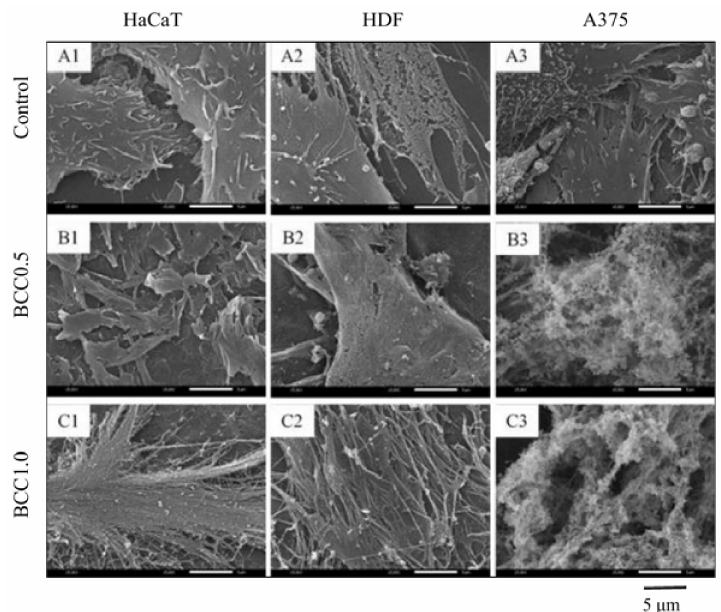
Figure 8. SEM images (5000 × magnification) showing cytotoxic effects of BCC0.5 (Row B ) and BCC1.0 (Row C ) against plain cover class (Row A , control) on HaCat (Column 1 ), HDF (Column 2 ), and A375 (Column 3 ) cells after 48-h